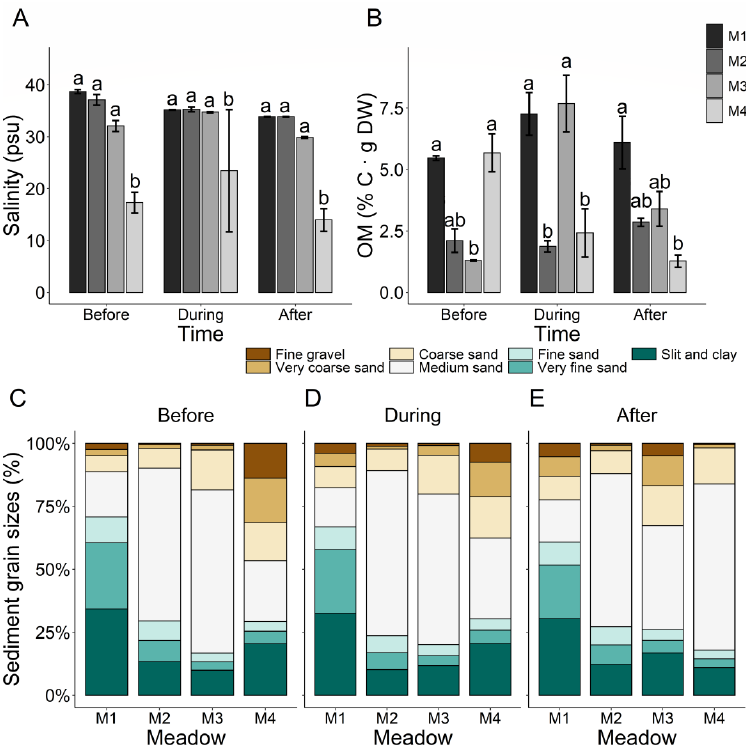
Figure 3. Salinity ( A ), organic matter content ( B ) and percentages of each sediment grain size ( C – E ) (mean ± SE; n = 2) amidst the four studied Z. noltei meadows (M1 – M4) before, during and after the flowering period. Letters above error bars indicate significant differences among meadows. The sediment grain sizes also revealed a high spatio-temporal variability in the Z.